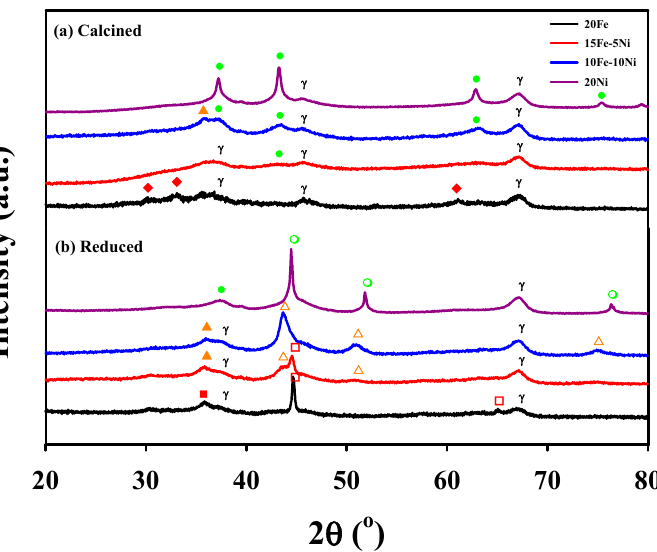
Figure 1. XRD patterns of the ( a ) calcined and ( b ) reduced Ni, Fe, and Fe-Ni catalysts; ( γ ) γ -Al 2 O 3 , ( ◆ ) Fe 2 O 3 , ( ■ ) Fe 3 O 4 , ( □ ) Fe metal, ( ● ) NiO, ( ○ ) Ni metal, ( ▲ ) NiFe 2 O 4 , and ( △ ) Ni-Fe alloy. Table 1. Characterization of the catalysts.